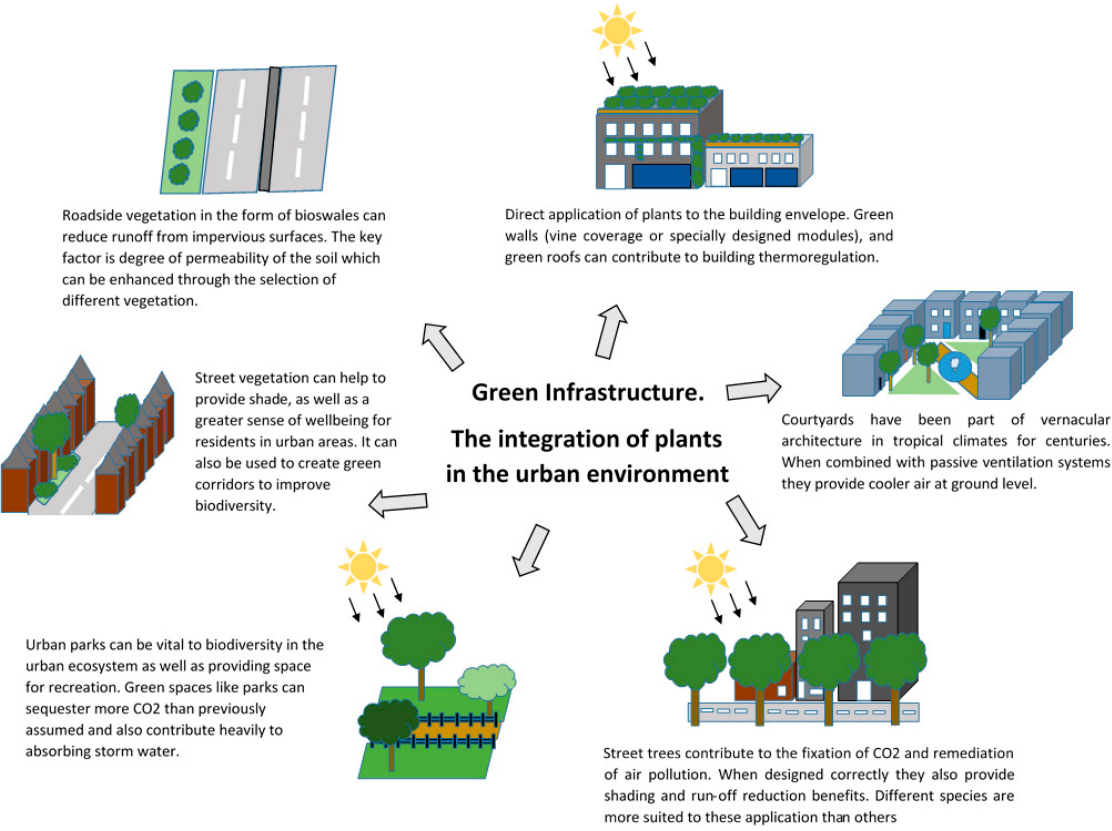
Figure 2. Examples of urban green infrastructure and their potential contributions to the health and wellbeing of urban dwellers.